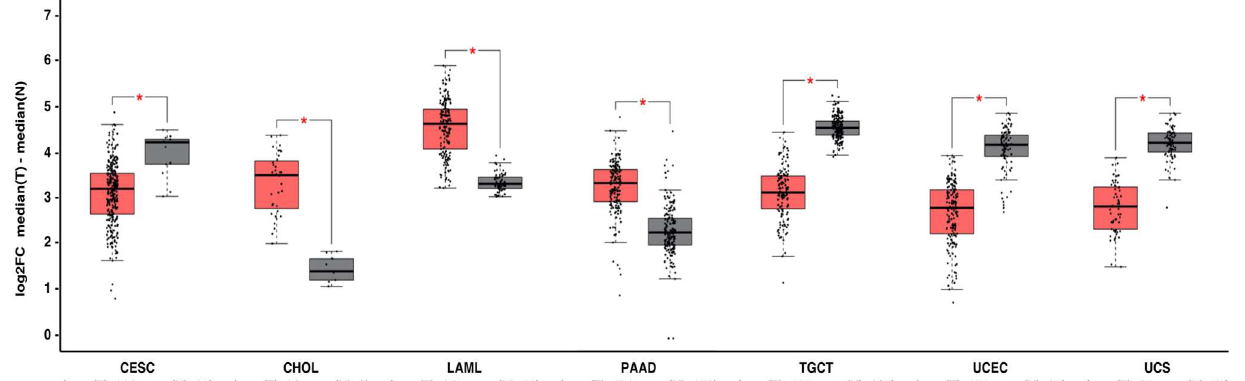
Figure 5. MNT can act as a tumor suppressor gene or oncogene depending on the tumor type. Gene expression profiling interactive analysis (GEPIA, http://gepia.cancer-pku.cn/, accessed on 7 July 2021) was performed to validate MNT mRNA expression in selected cancer type samples (in red) vs. normal samples (in grey). The expression data were first log2(TPM+1) transformed for differential analysis, and the log2FC was defined as median (tumor)–median (normal). Data are represented as mean ± SD (* p < 0.01). Abbreviations: CESC, cervical squamous cell carcinoma and endocervical adenocarcinoma; CHOL, Cholangiocarcinoma; LAML, acute myeloid leukemia; PAAD, pancreatic adenocarcinoma; TGCT, testicular germ cell tumors; UCEC, uterine corpus endometrial carcinoma; UCS, uterine carcinosarcoma.